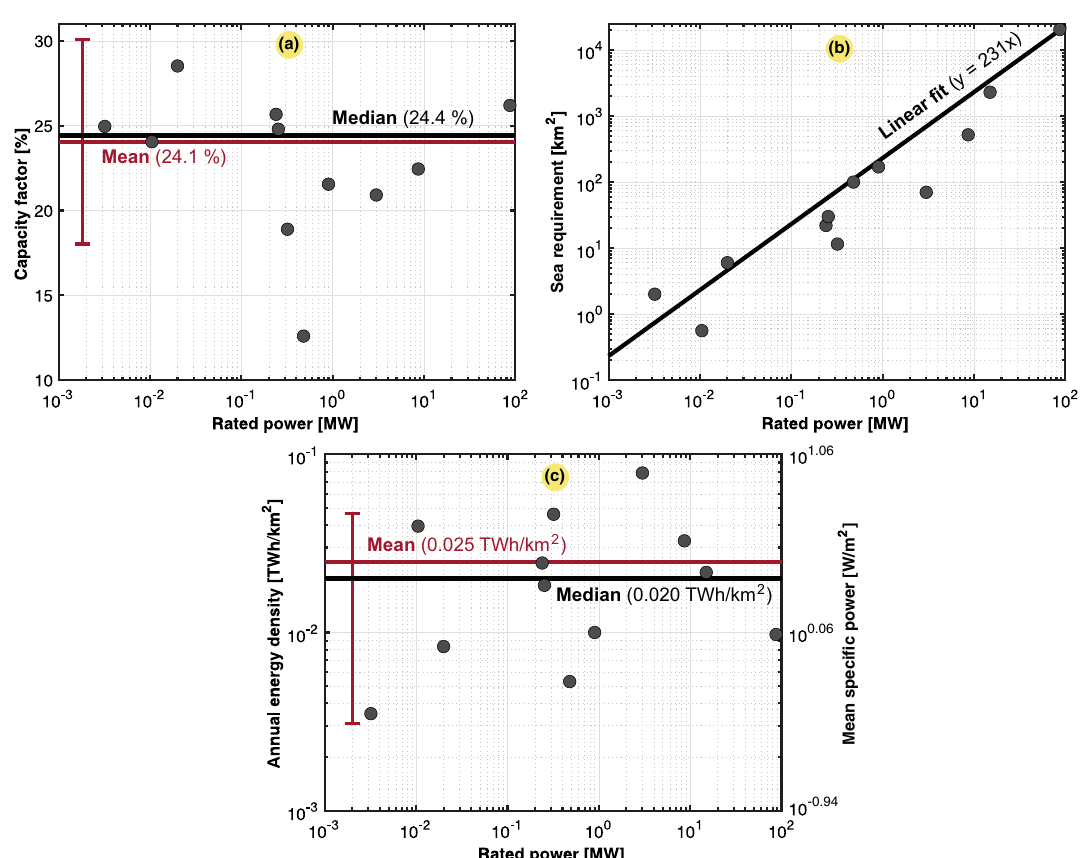
Figure 12. Case study of 12 tidal power plants worldwide ( n = 12 ), 2 in the CIS (Russia), 1 in North America (Canada), 5 in Europa (1 in France and 4 in the UK), and 4 in Asia Pacific (1 in China, 1 in India, and 2 in South Korea). Typical, mean, median, and fitted values are also included. ( a ) Capacity factor ( C g ). ( b ) Land use ( A g ). ( c ) Annual energy density ( ε g ) or mean specific power ( p g